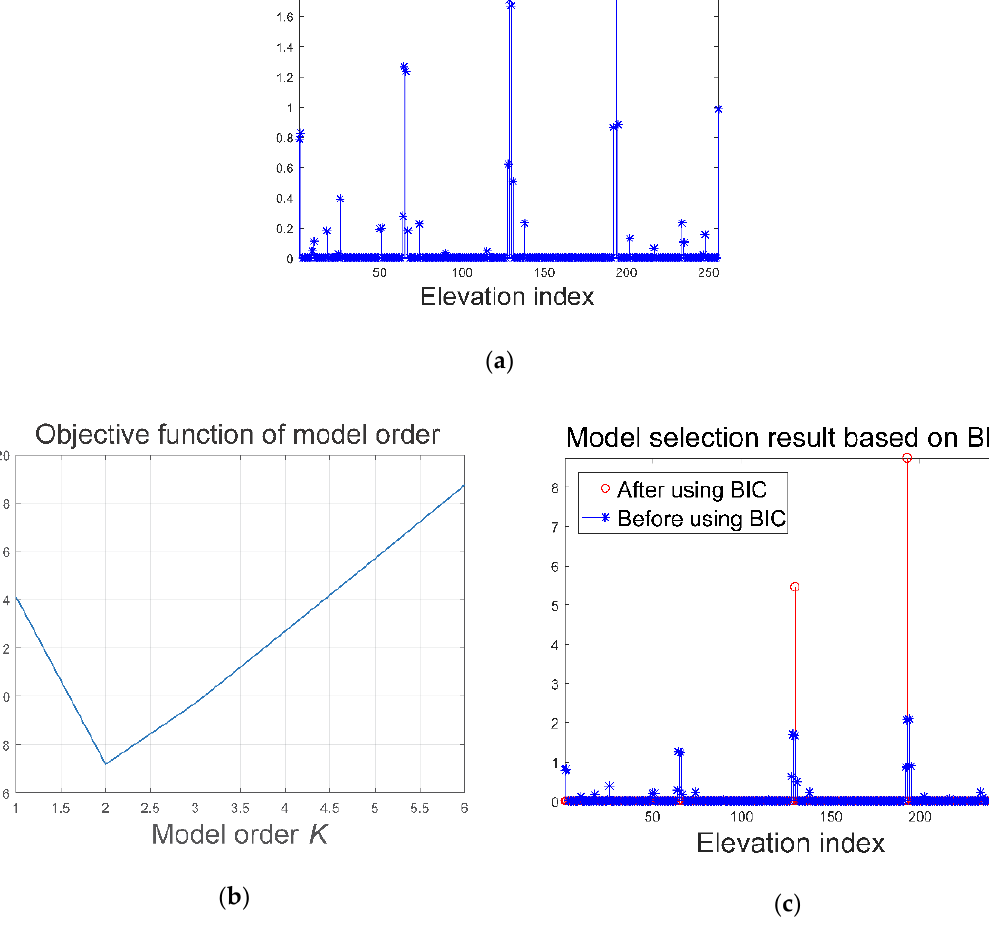
Figure 4. Model order selection results. ( a ) Initial result of the elastic net regression; ( b ) relations between model order K and the objective function; ( c ) optimized result after using BIC criterion.